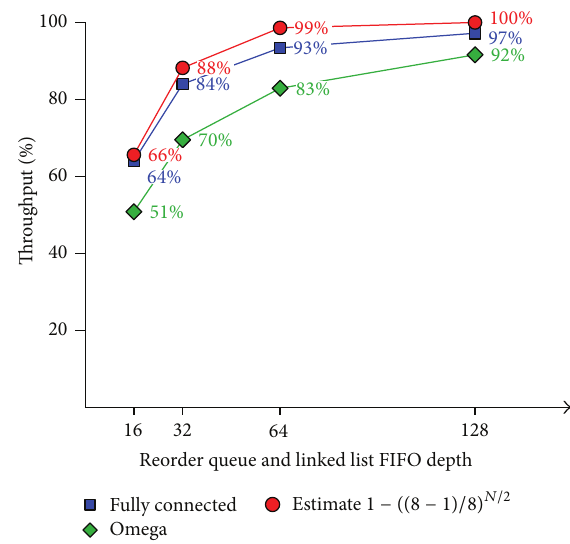
Figure 15: The effect of varying the depth of the linked list FIFOs and reorder queues on throughput of the random memory access benchmark (using 8-port